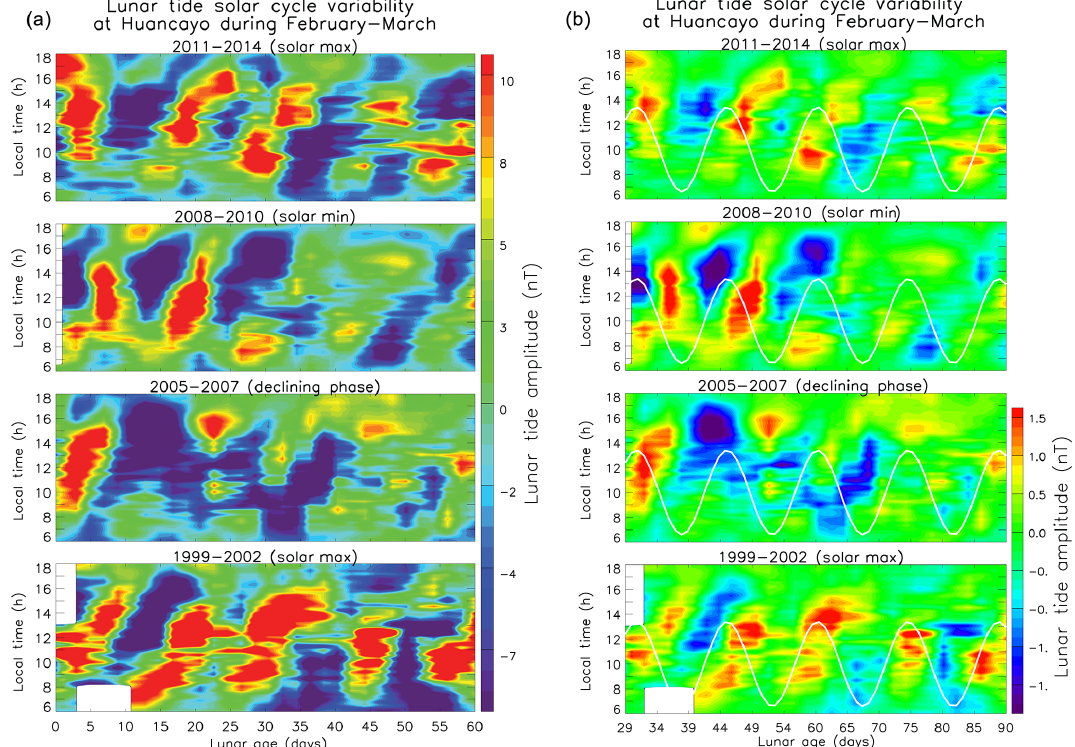
Figure 5. (a) The lunar tidal wave amplitude difference observed at Huancayo during different solar activity periods, which is given at the top of each panel; (b) same format as (a) but for the residuals normalized by the square root of the daily solar